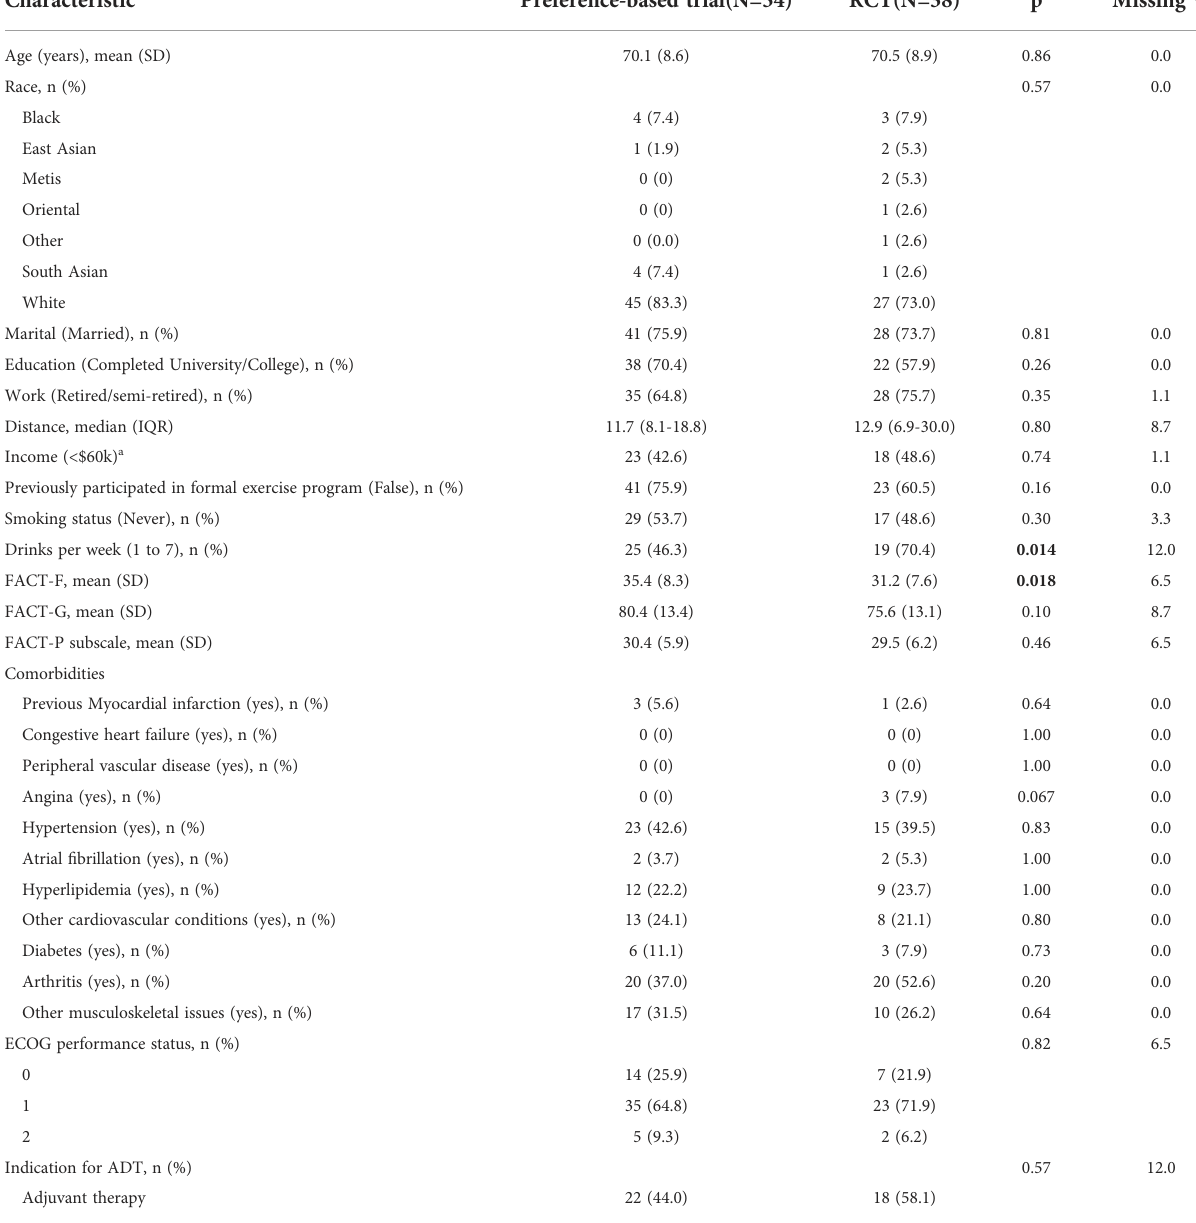
TABLE 2 Baseline characteristics between participants in the preference-based and randomized controlled trials.